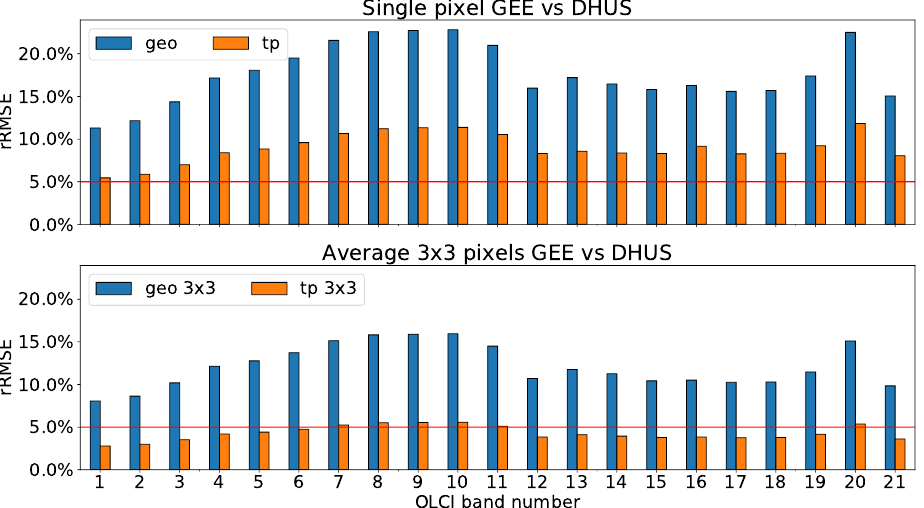
Figure 5. Sentinel-3 OLCI from GEE and DHUS. Note that the data are supposed to be identical (rRMSE = 0). The red line denotes the subjective acceptance threshold of 5%